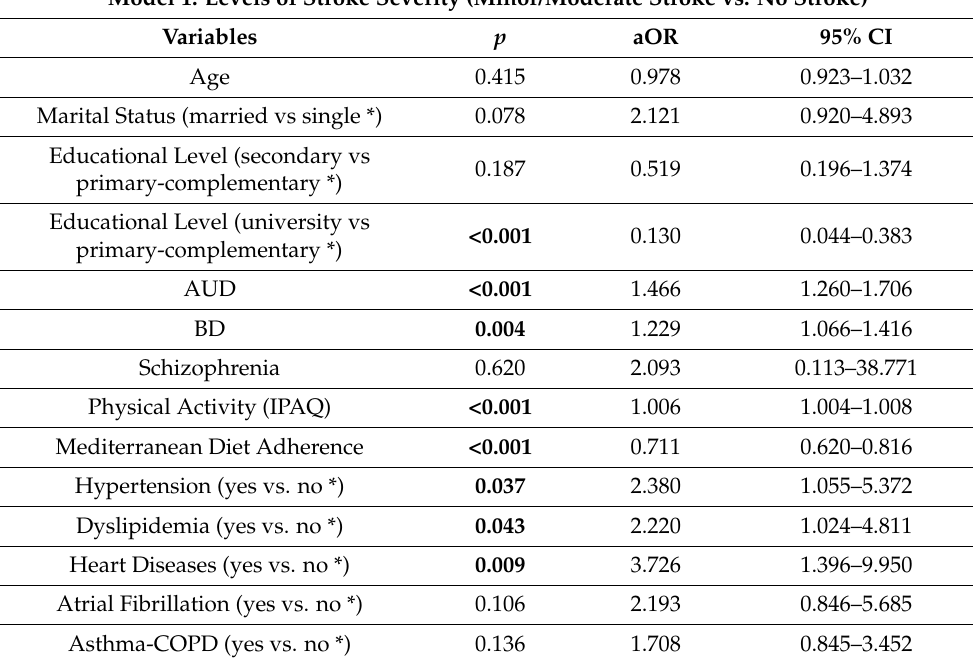
Table 5. Multivariable analysis: multinomial regression taking the levels of stroke severity. Model 1: Levels of Stroke Severity (Minor/Moderate Stroke vs. No